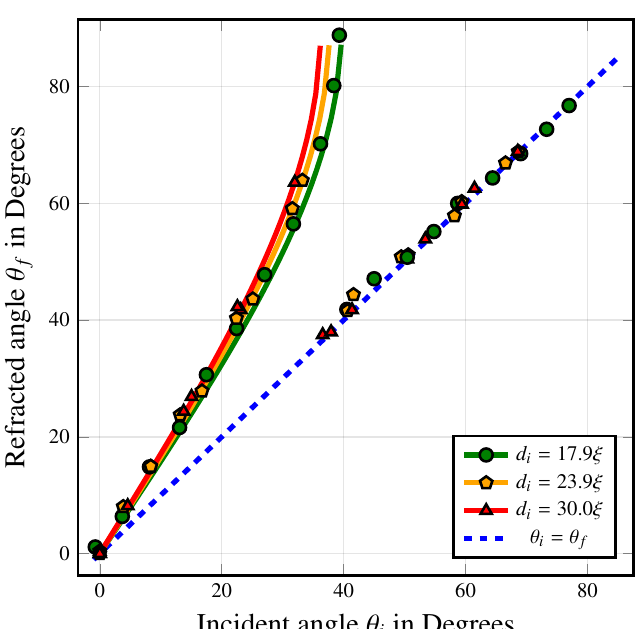
/ρ = 8.5 / 10) with Figure 4: Incident vs refracted angle across the large step ( ρ 1 2 = 17.9 ξ ), medium ( d = 23.9 ξ ) and high ( d = 30.0 ξ ) energy dipoles. low ( d i i i Data points on the dashed blue line represent a dipole undergoing total internal reflection, with the incident angle equal to the refracted angle. The solid lines are the predictions of Eq. (19a) for each initial dipole separation distance